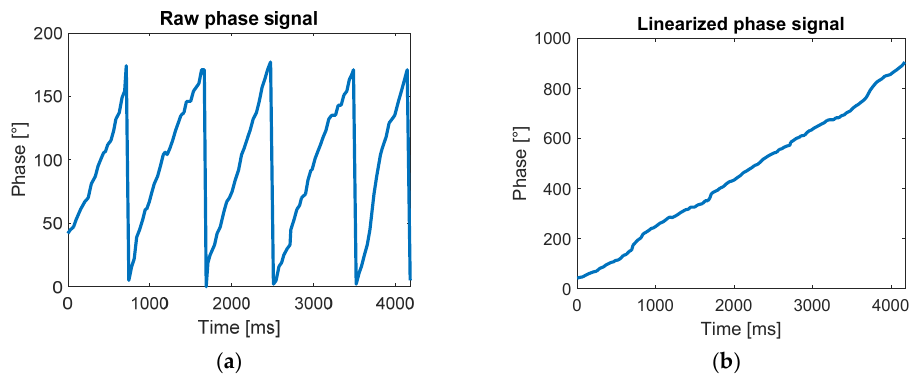
Figure 3. The figure shows the unwrapping of the signal: ( a ) shows the raw phase signal during the movement of the antenna toward the tag and ( b ) shows the same signal after the application of the unwrapping. The signal shown was acquired during the linear movement of the antenna toward the tag. The tag was fixed to a support, while the antenna was moved by hand on a rectilinear path toward the antenna.